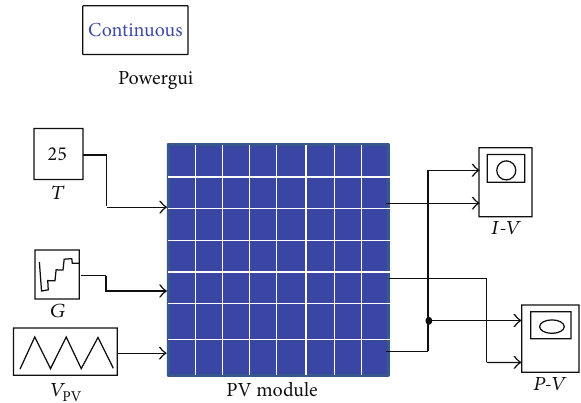
Figure 2: PV module with radiance variation.